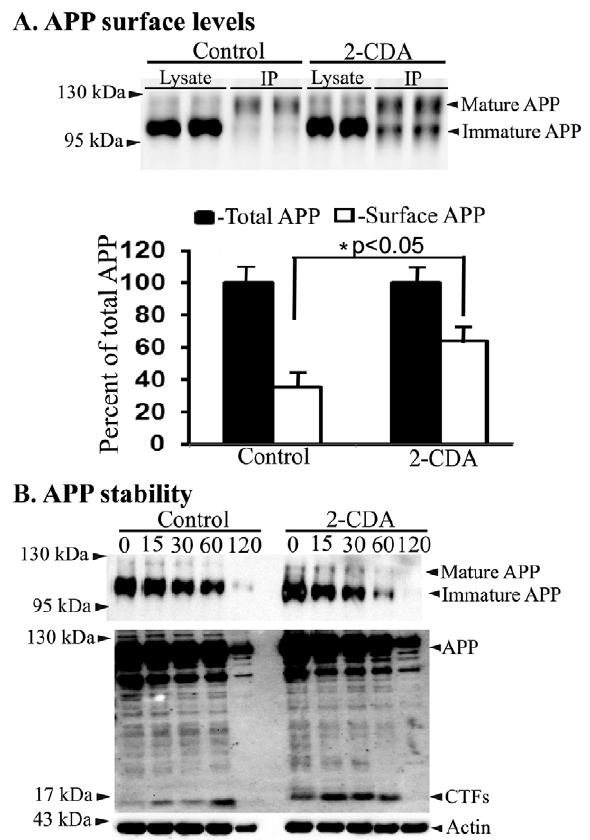
Figure 3. 2-CDA increases surface levels of APP and its turnover. (A) 7WD10 cells were treated with 2-CDA at 1.0 m M concentration followed by cycloheximide chase at indicated time points in 2-CDA treated and untreated cells (upper panel). The lower panel is the overexposed blot to show accumulation of CTF levels in 2- CDA treated cells versus controls at different chase times. (B) Surface biotinylation and biotin immunoprecipitation showed significantly increased surface levels of APP in 2-CDA treated 7WD10 cells compared to untreated cells. (C) Quantitation of immunoblot signals by imageJ revealed significant differences (p , 0.05) in surface levels of APP but not in the levels of total APP in 2-CDA treated cells versus controls. Values are expressed as percentage change in surface levels of APP in control versus 2-CDA treated cells. For all samples, n=4. *, p , 0.05 versus control by student t test.